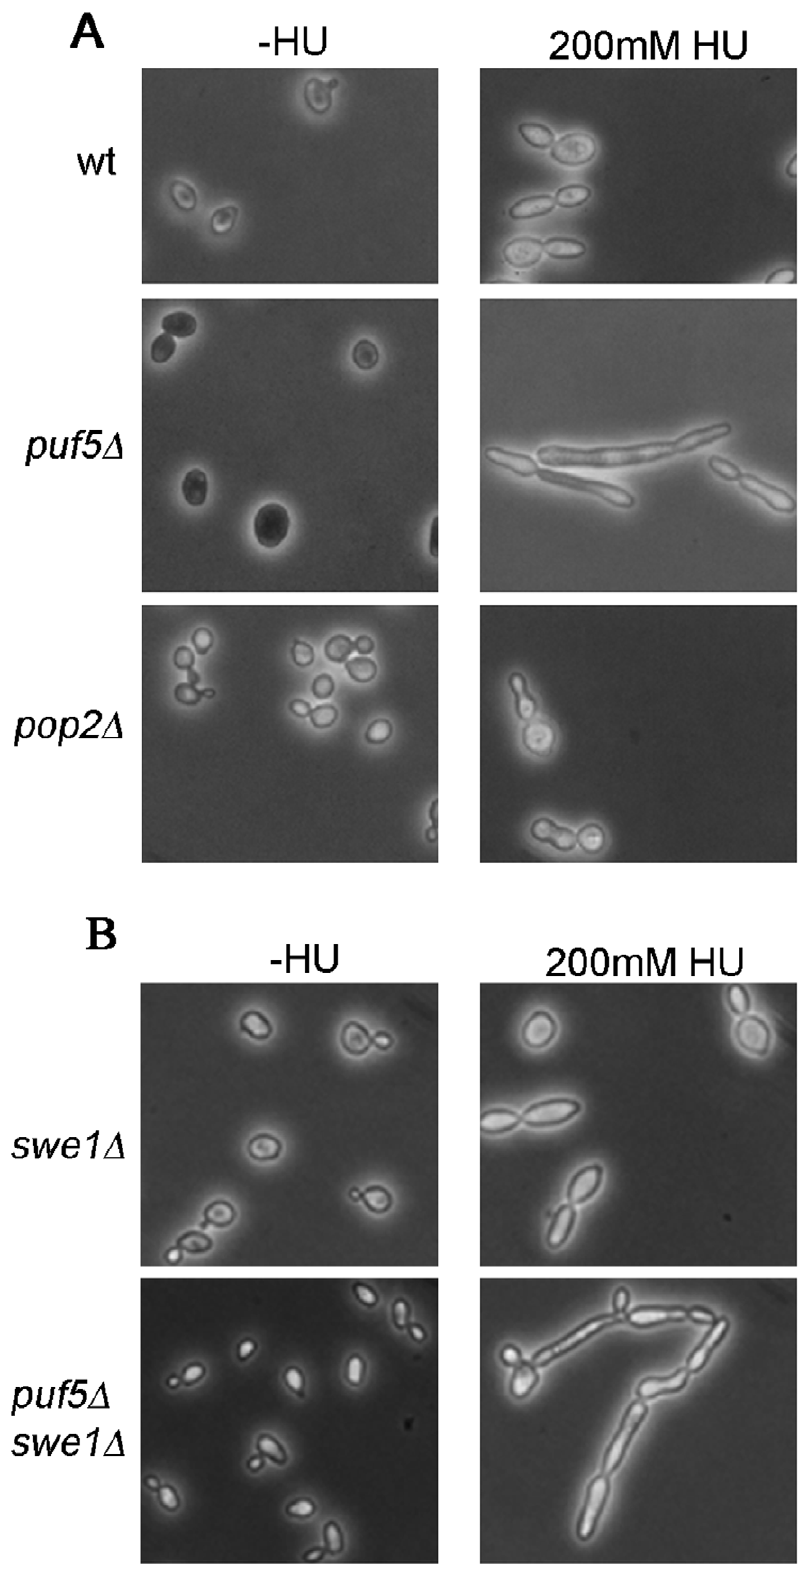
Figure 3. puf5 mutants display a Swe1-independent elongated cell morphology in response to HU. Cells of the indicated strains were grown in the presence or absence of 0.2 M HU for 16 h, fixed in 70% ethanol, rehydrated in PBS and viewed.